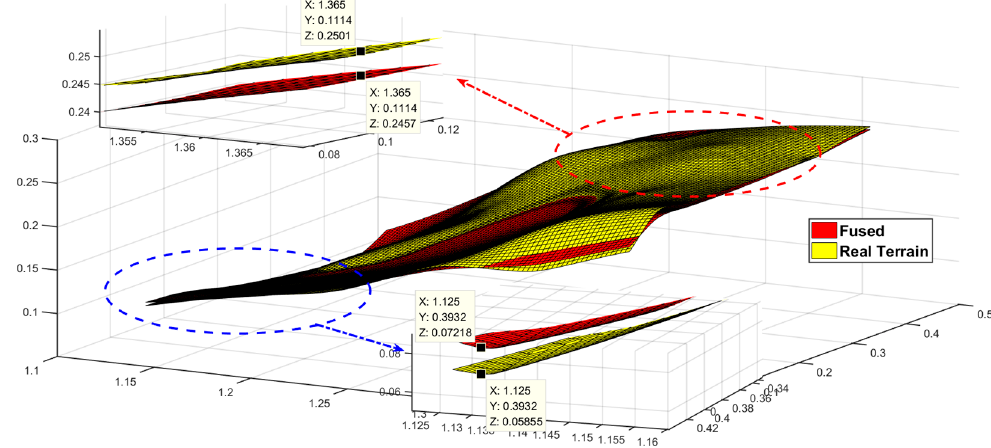
Figure 14. Comparative analysis of the estimated terrain and real terrain.